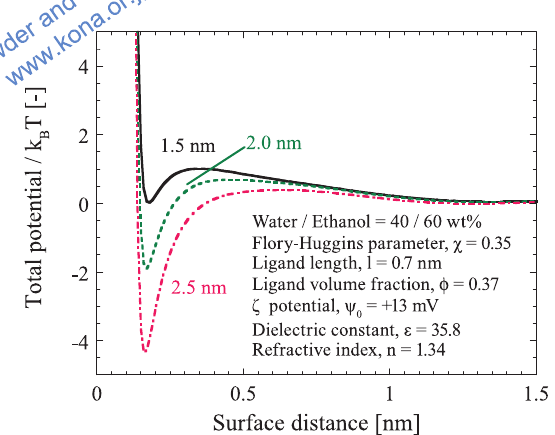
Fig. 6 Total particle interaction potential for the particles of 1.5, 2.0, and 2.5 nm diameter at 60 wt% of the ethanol concentration in